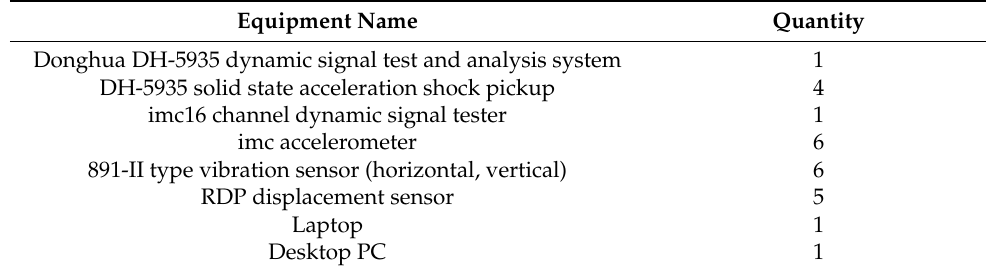
Table 1. Dynamic testing of collecting systems.